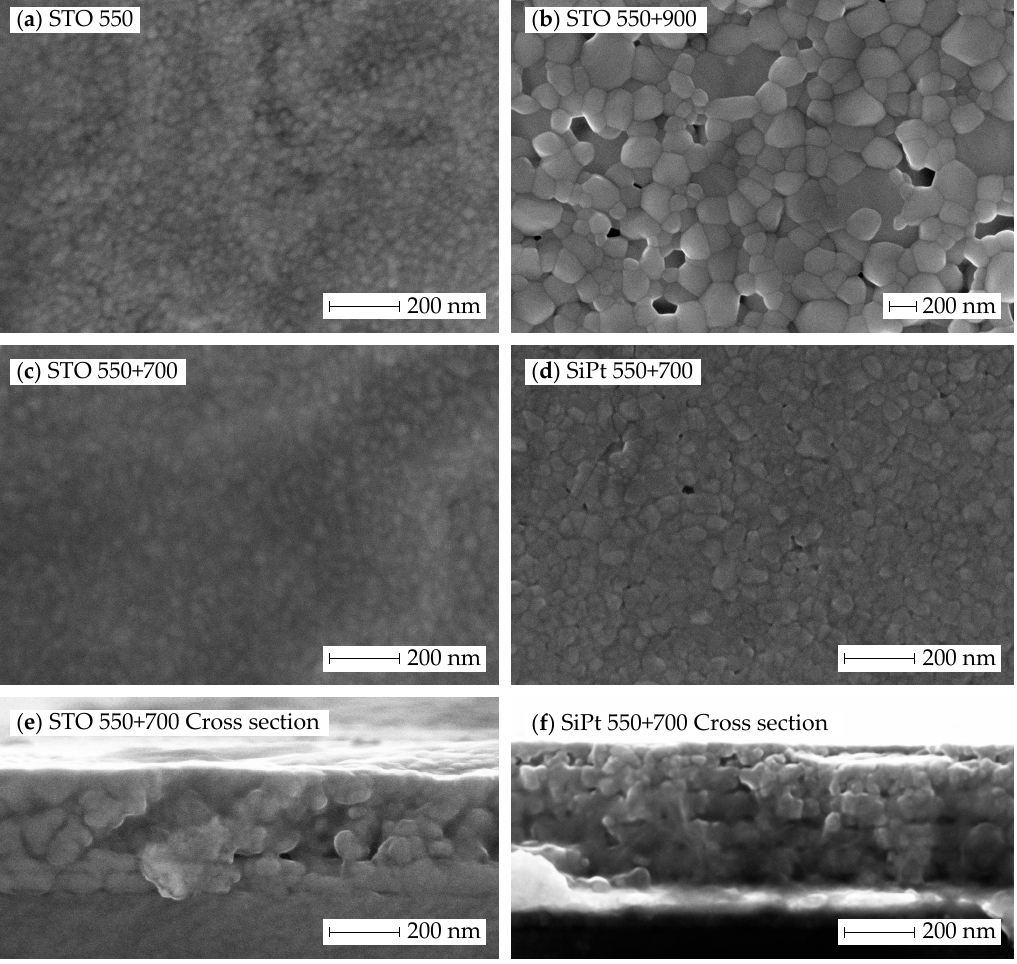
Figure 2. Secondary electron scanning electron microscope (SEM) images of phase pure BNT films